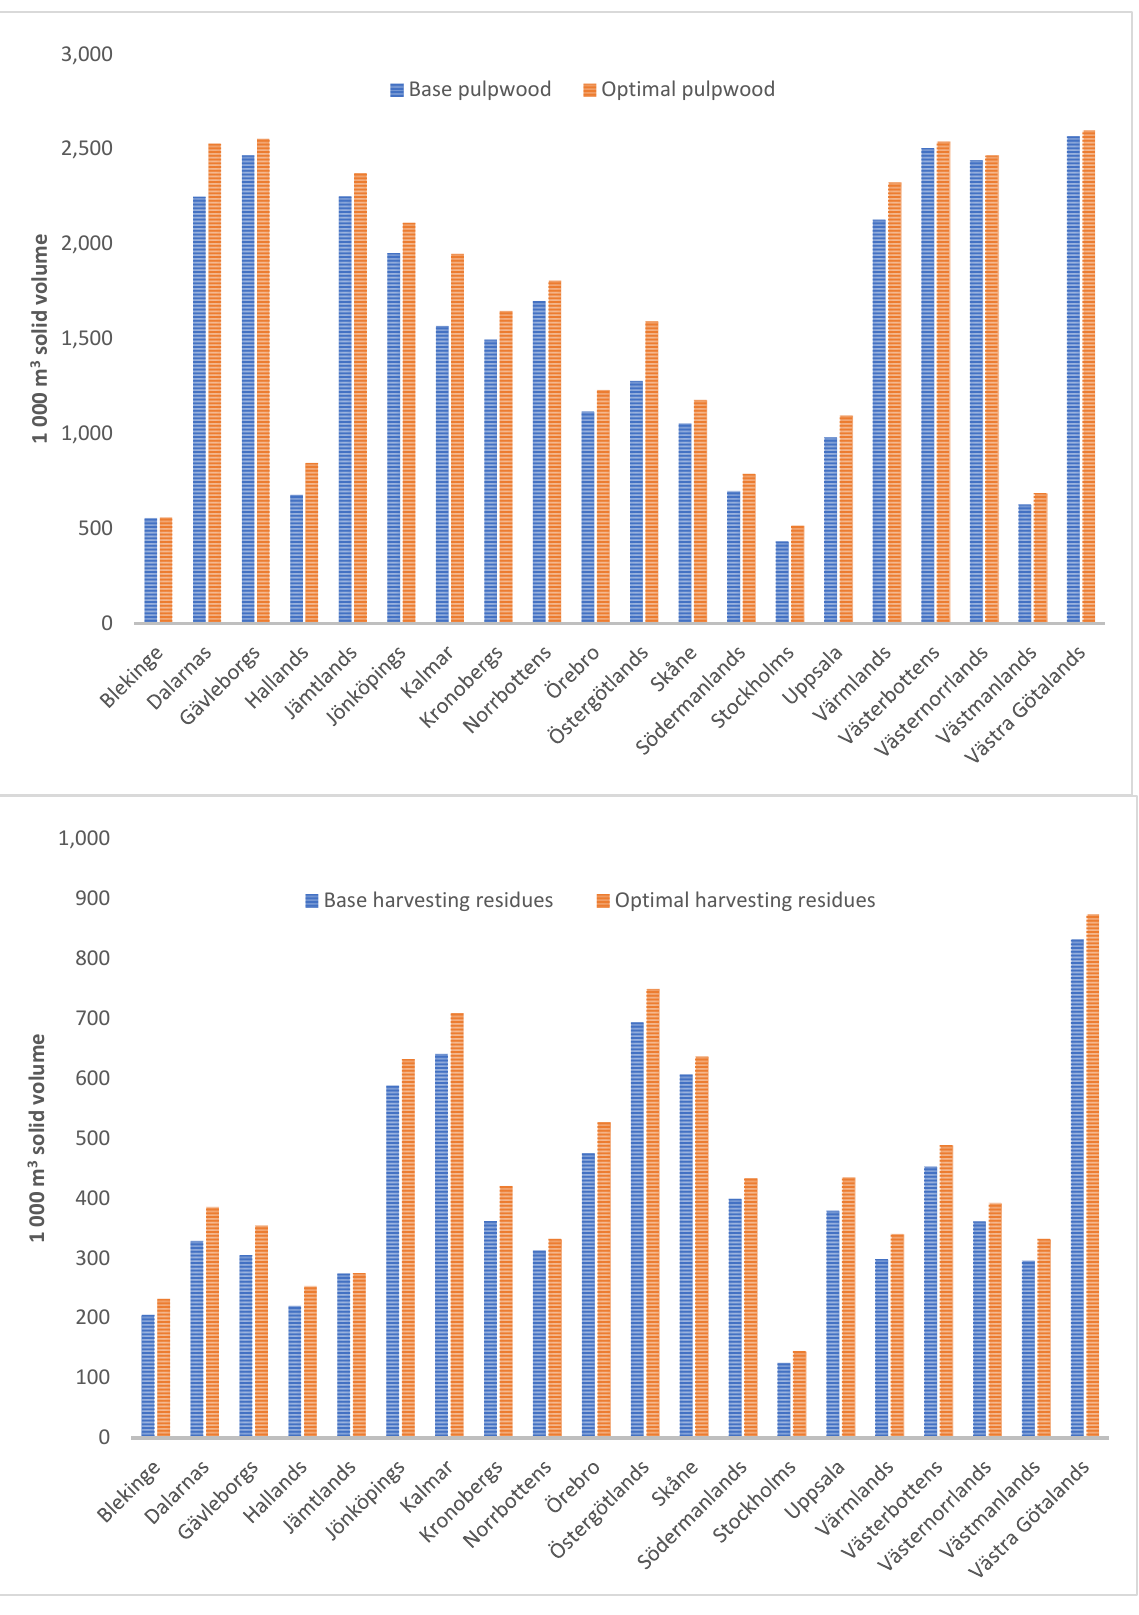
Figure 2. Average optimal extraction of sawlogs, pulpwood, harvesting residues and fuelwood between 2008 and 2014 by county in Sweden.